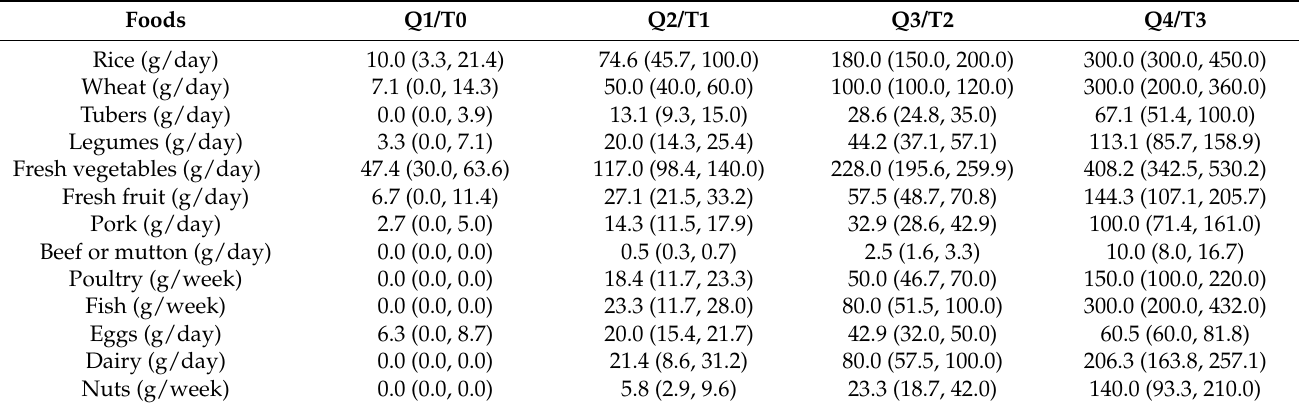
Table 1. Food consumption levels of Chinese adults aged 55 years and above in four provinces in CCSNSD 2018–2019 a .